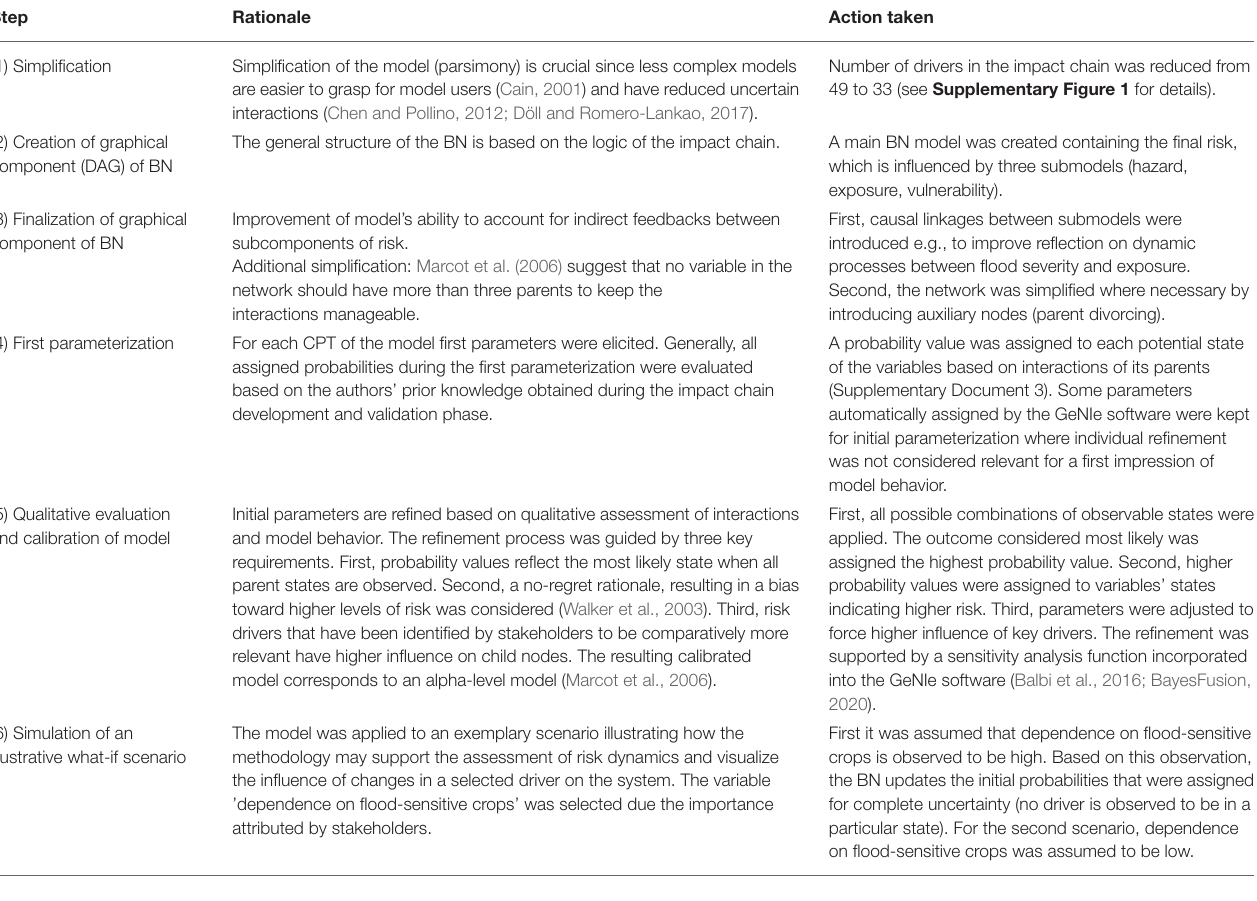
TABLE 1 | Six-step methodology from impact chain to Bayesian